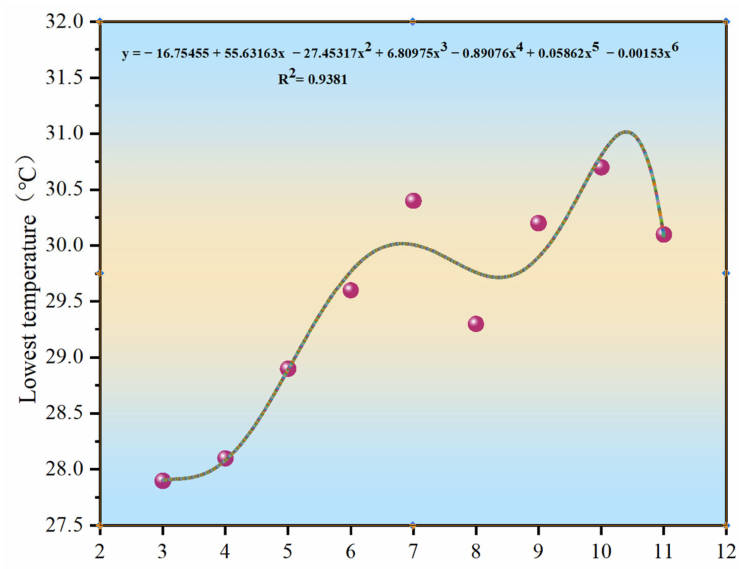
Figure 6. Distribution curve of the minimum temperature.